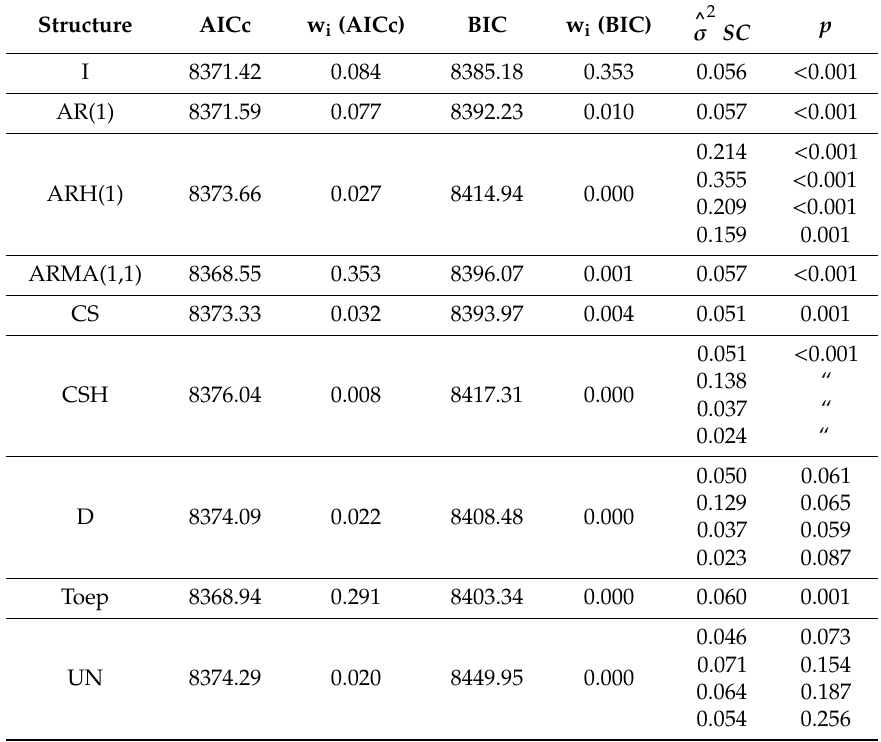
Table 5. Adjustment AICc and BIC coe ffi cients and relative weight of each (w i ). Estimated residual variance ( ˆ S 2 r ) was 0.183 in all items, covariance estimation of the random e ff ect –or levels– ( ˆ σ 2 SC) and p-value as a single value or main diagonal value (random e ff ect levels), according to the covariance matrix